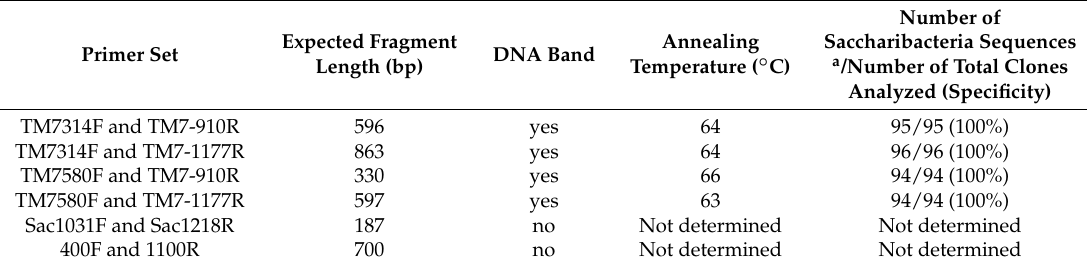
Table 2. Annealing temperature and specificity of Saccharibacteria-specific primer sets tested in this